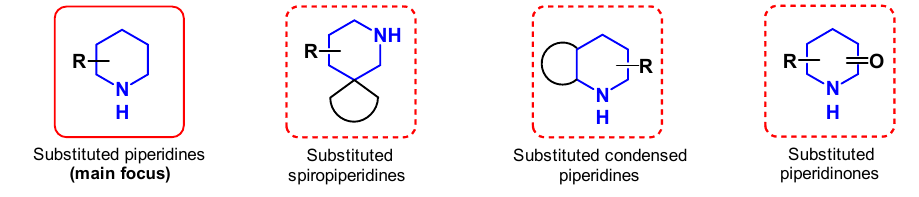
Figure 1. Piperidine derivatives scope of this review.